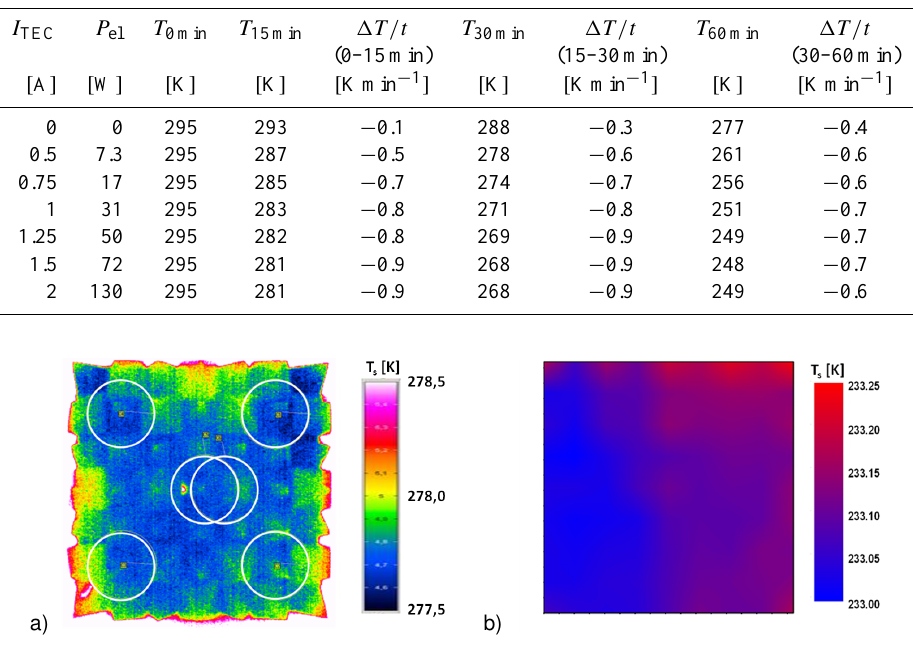
Fig. 12. Radiance temperature distribution of the black optical surface: (a) infrared image of the 2008 prototype taken by a thermographic camera in the lab (ambient T and p ) with the white circles representing the FOV of individual GLORIA detector pixels. (b) GBB-H flight model radiance temperature measured by VIRST at the RBCF of PTB ( T GBB =233K). Depicted is the smoothed distribution of radiance temperature resulting from a measured grid of 11 by 11 points.